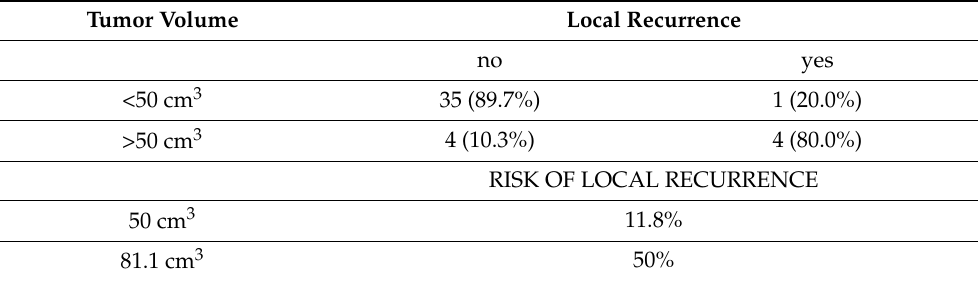
Table 3. Distribution of patients with tumor volumes </> 50 cm 3 and local recurrences. Non-linear regression model reveals the above presented risks for local